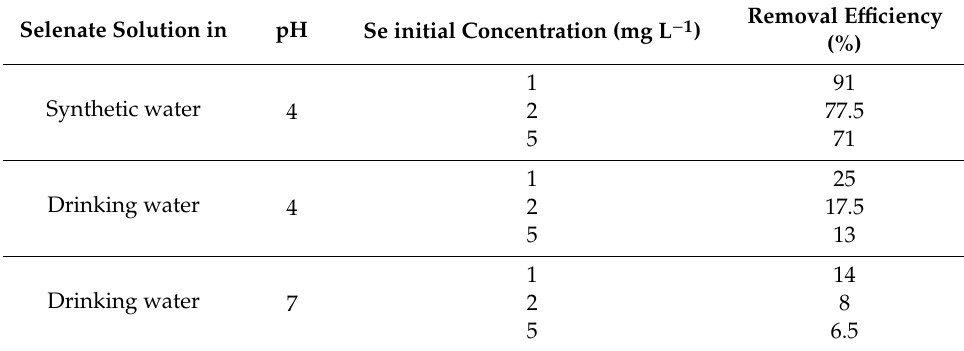
Table 4. The removal e ffi ciency of selenate by the ER / DETA / FO / FD adsorbent from drinking water. Selenate Solution in pH Se initial Concentration (mg L − 1 ) Synthetic water 4 Drinking water 4 Drinking water 7